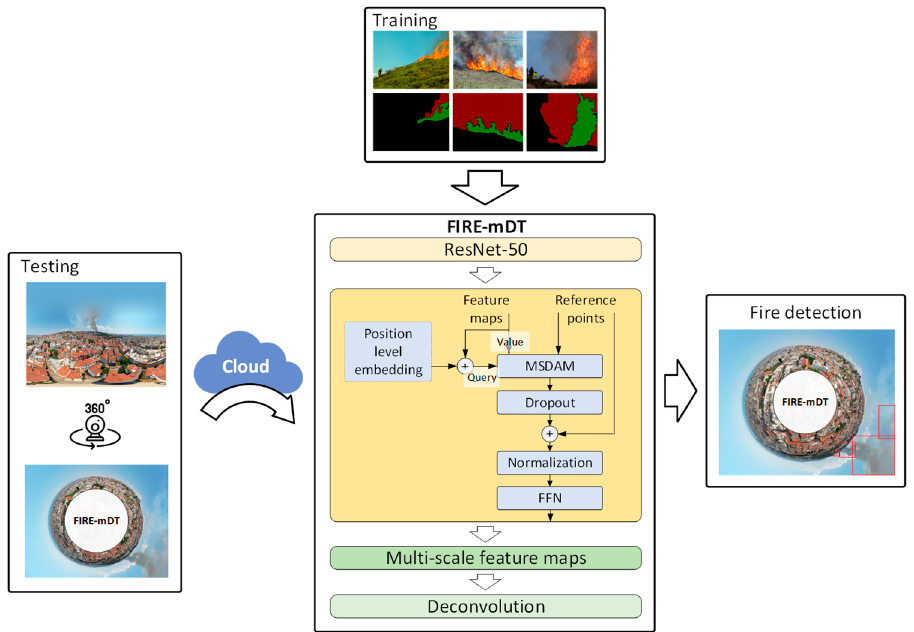
Figure 9. The proposed methodology for early fi re detection.